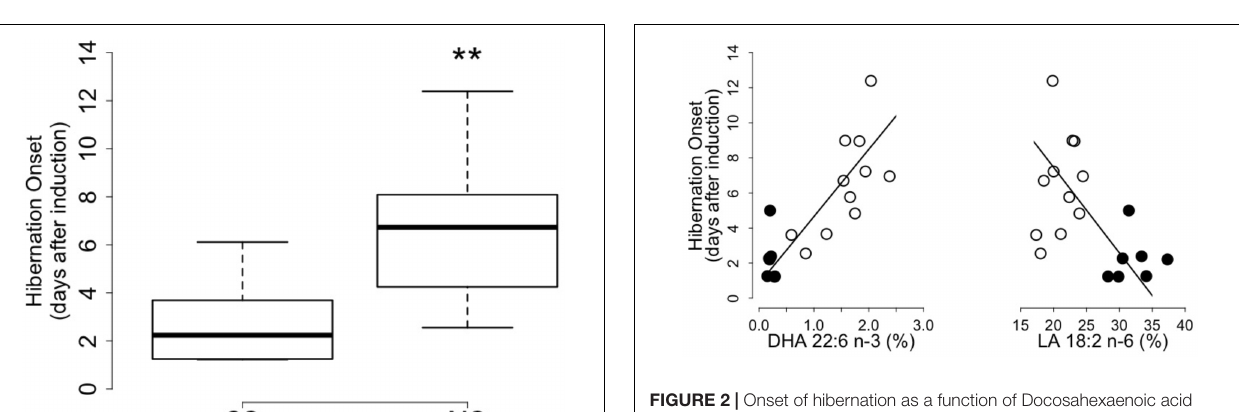
FIGURE 2 | Onset of hibernation as a function of Docosahexaenoic acid (“DHA 22:6 n-3,” left panel) and Linoleic acid (“LA 18:2 n-6,” right panel) levels in WAT total lipids of garden dormice fed either a n-6 PUFA-enriched (black dots) or a n-3 PUFA-enriched diet (open dots). Regression statistics from linear ranged major axis analysis: (DHA) intercept = 0.83, slope = 3.83, adjusted R 2 = 0.65, p < 0.001; (LA) intercept = 17.20, slope = –0.49, adjusted R 2 = 0.25, p <